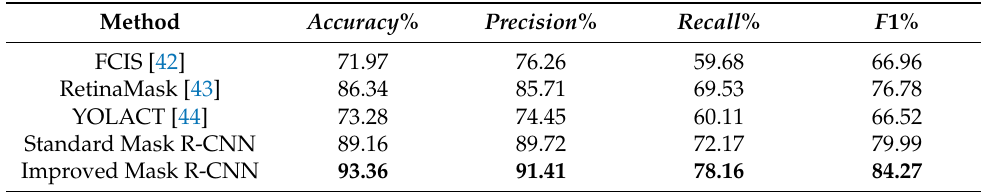
Table 2. Experimental results of instance segmentation on the self-created dataset.